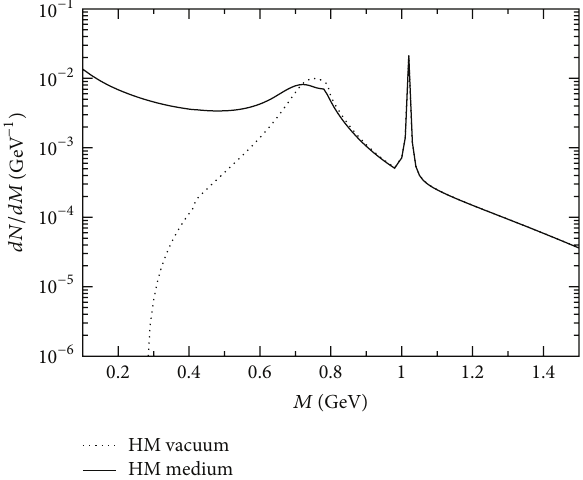
Figure 24: Invariant mass distribution of dileptons from hadronic matter (HM) for modified and unmodified 𝜌 meson for RHIC